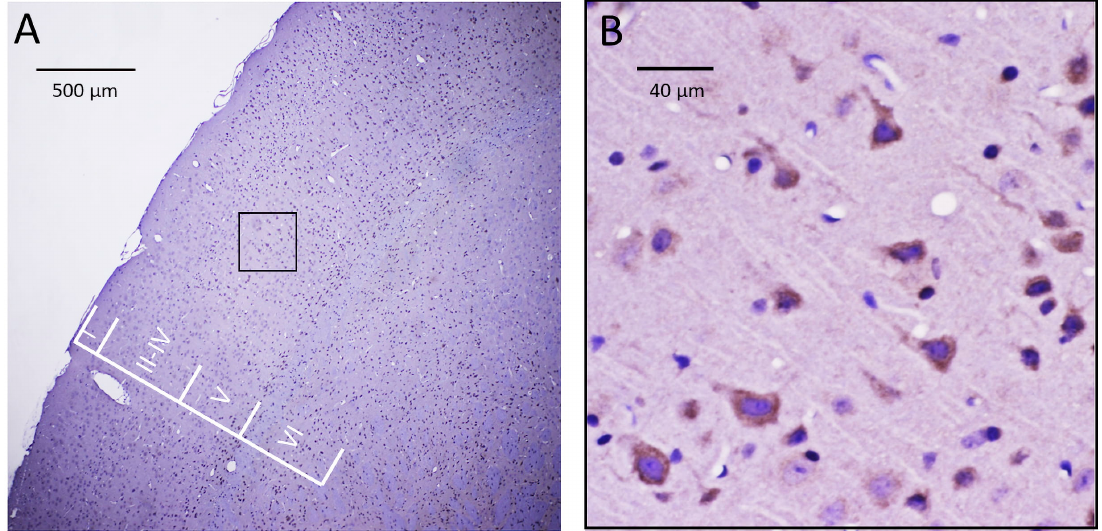
Fig. 2. Immunohistochemical localization of Piezo2 in a sagittal slice of mouse neocortex. (A) The anti-PIEZO2 Ab stained many cells throughout layers II–VI of the neocortex with minimal staining of cells in layer I. (B) The selected region in A (i.e., within the black box) representing a region within layer V is shown at higher magnification and indicates the most commonly stained cells displayed a pyramidal-shaped cell body with a thick process directed towards the pia (i.e., consistent with the apical dendrite of a pyramidal neuron). In contrast, there was less clear evidence of the staining of multipolar cells indicative of either stellate neurons or astrocytes.